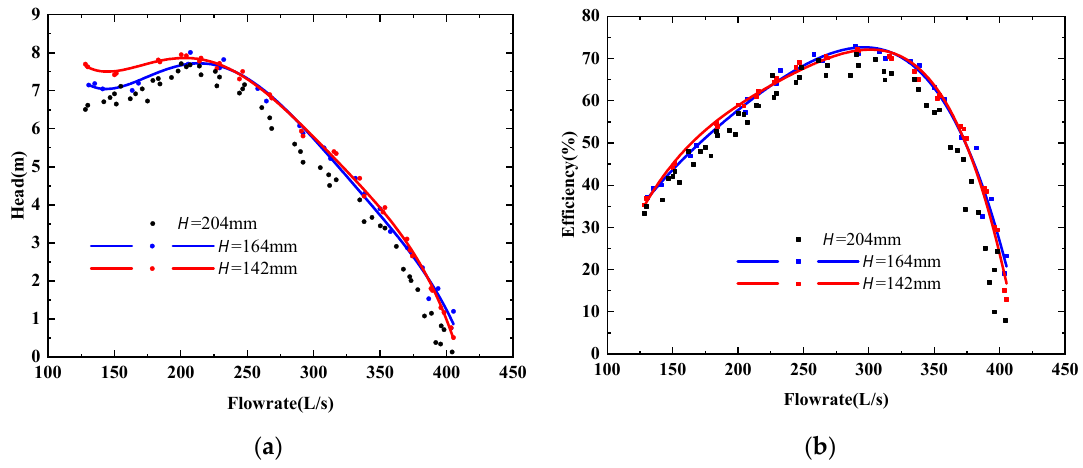
Figure 8. Comparison of performance curves: ( a ) Head curves; ( b ) Efficiency curves.